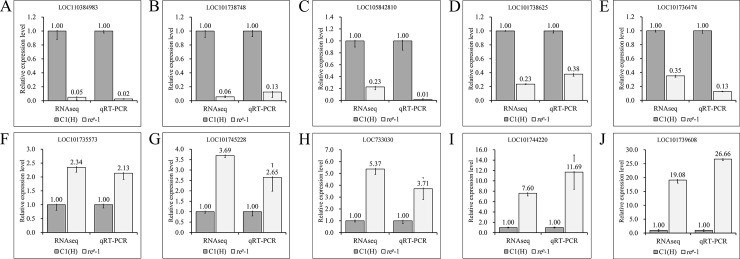
Relative expression of partial genes verified by qRT-PCR.The LOC number represented the gene ID in NCBI. All genes were closely consistent between RNA-seq and qRT-PCR, which indicated that the RNA-Seq data of RNA-seq are reliable.